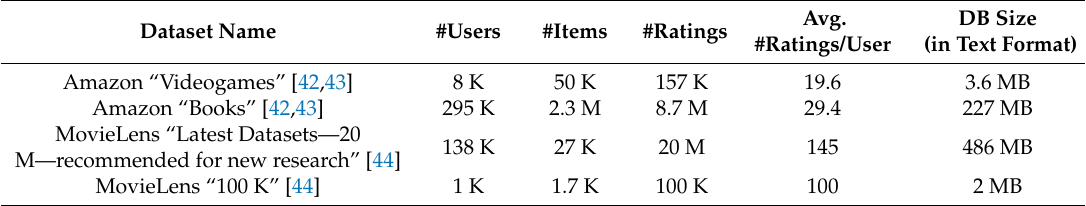
Table 3. Datasets